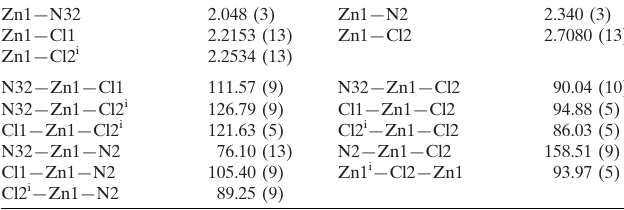
Selected geometric parameters (A˚ , (cid:2) ).